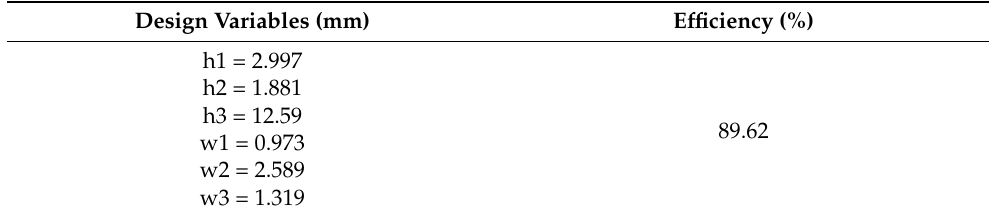
Table 6. Optimization result of the Type 3-1 rotor slot.